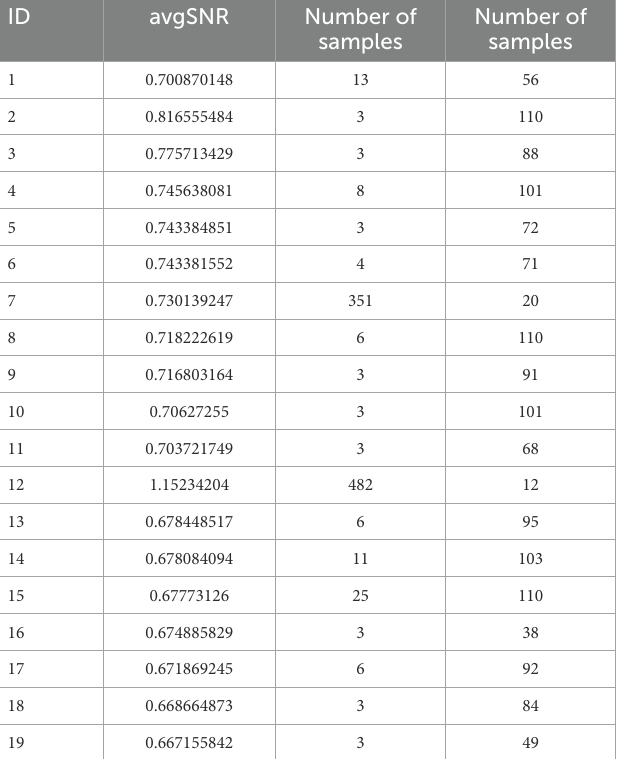
TABLE 1 Clustering results identified in the statistical method proposed in this paper based on the GDS37948 male infertility data set.